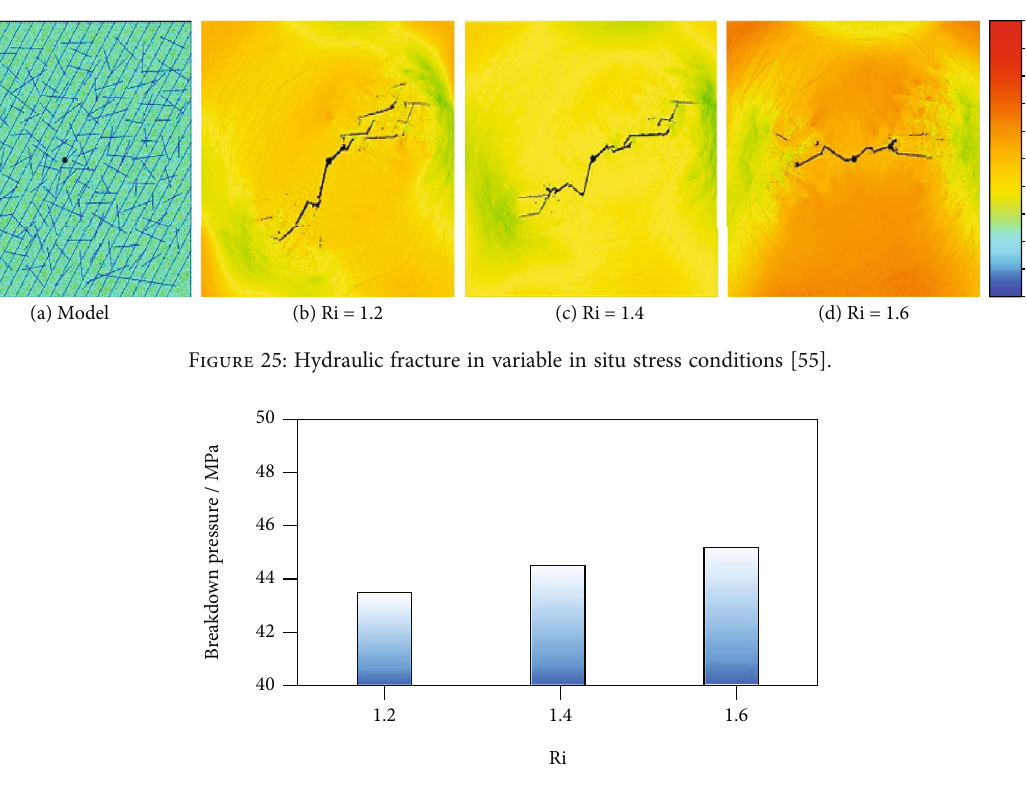
Figure 26: Breakdown pressure with variable in situ stress